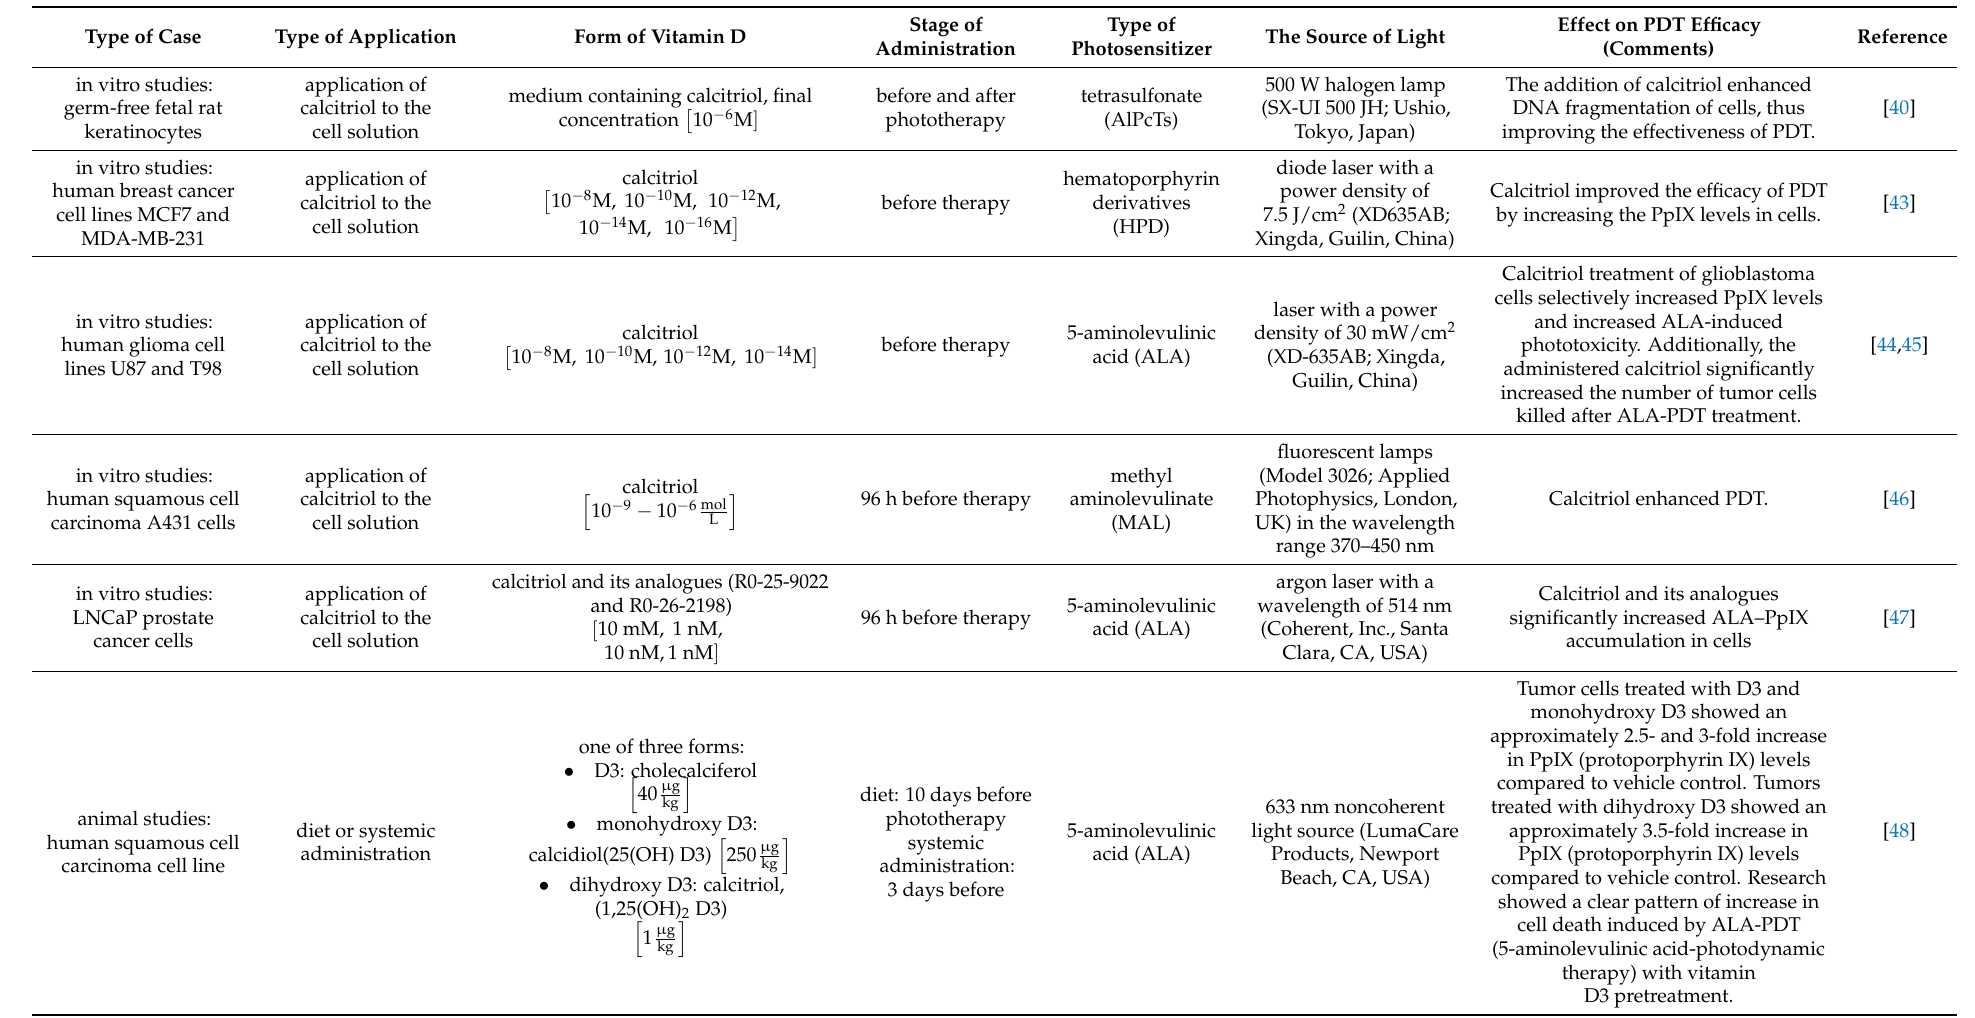
Table 1. Description of study